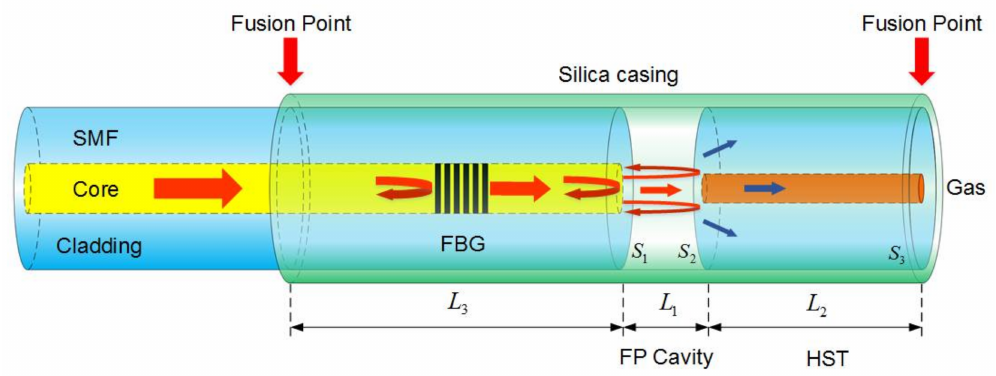
Figure 1. Schematic of the fiber-optic FP gas pressure sensor for high